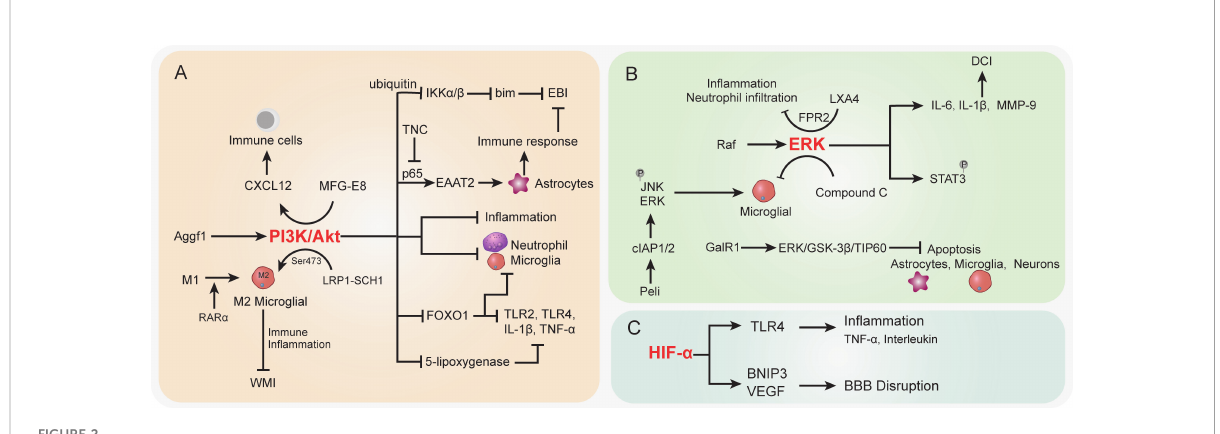
FIGURE 2 The speci fi c role played by PI3K/Akt (A) , ERK (B) , and HIF- a (C) pathways in disease development following SAH. CI, delayed cerebral ischemia; EBI, early brain injury; BBB, blood – brain barrier; WMI, white matter